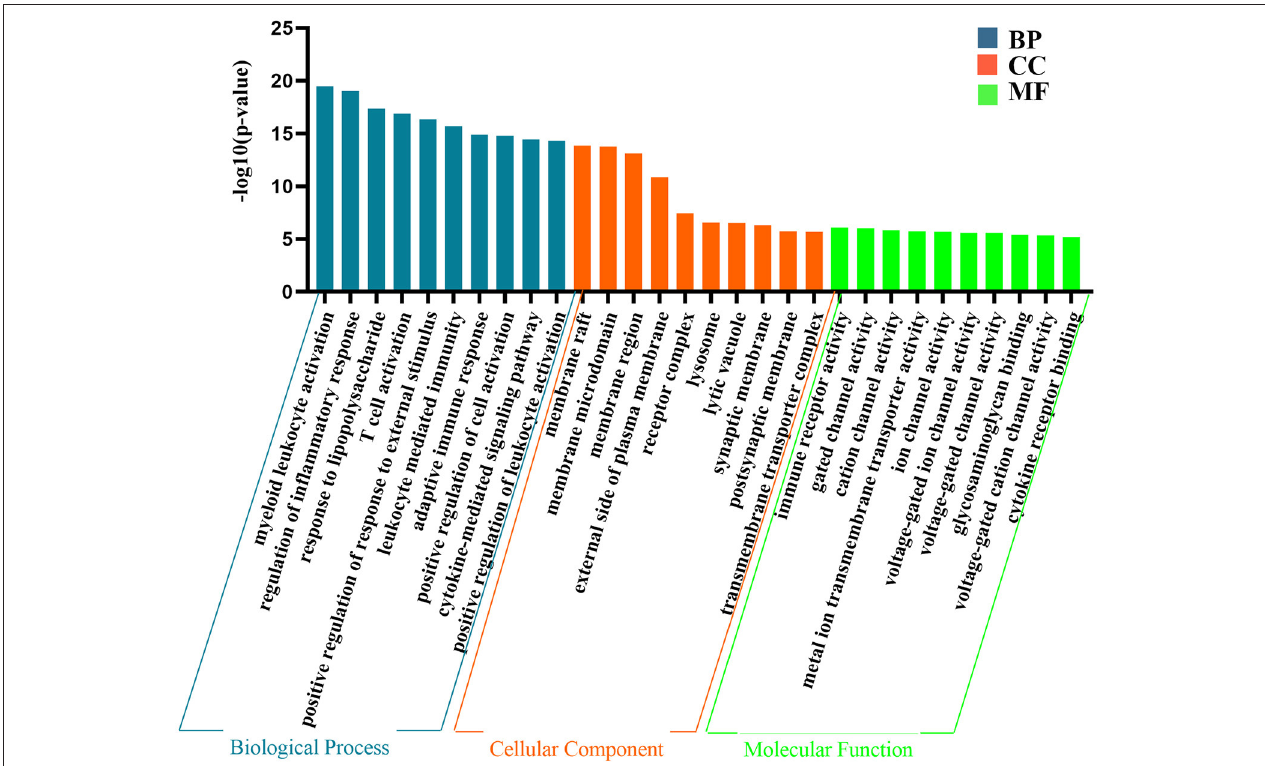
FIGURE 3 | The representative results of GO analysis using yellow module. The top 10 clusters of biological process, cellular component and molecular function were chosen separately according to –log10( P -value) ranking and displayed.